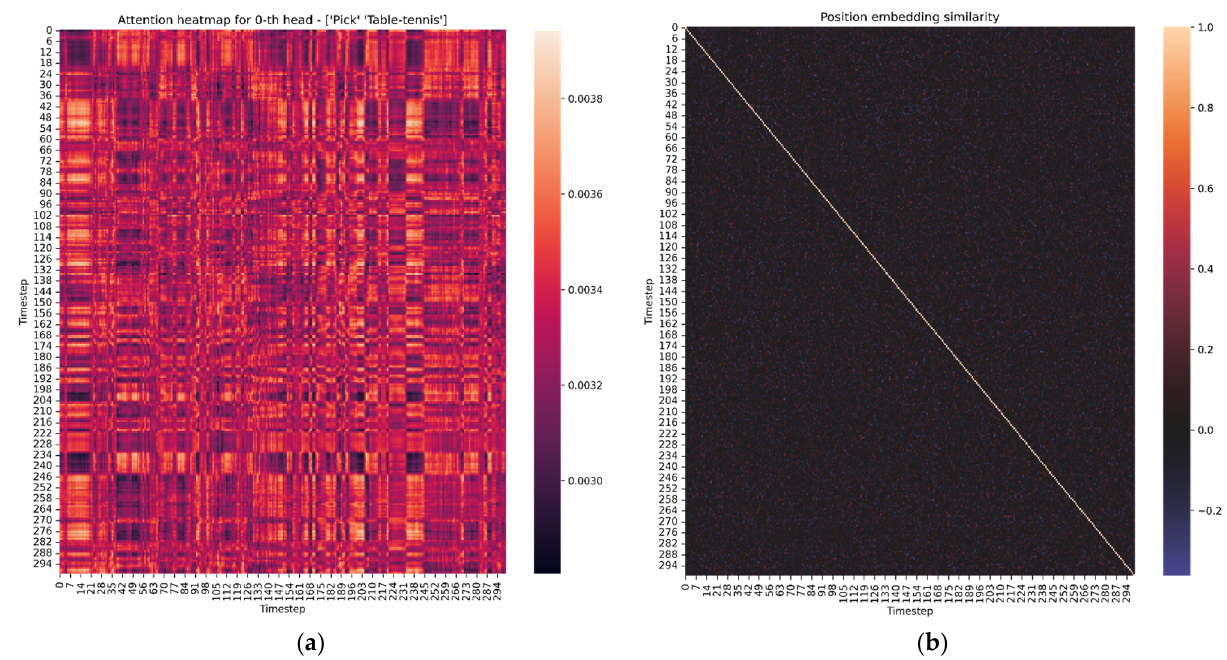
Figure 8. Visualization of: ( a ) Attention matrix; ( b ) position embedding similarity of randomly initialized transformer.